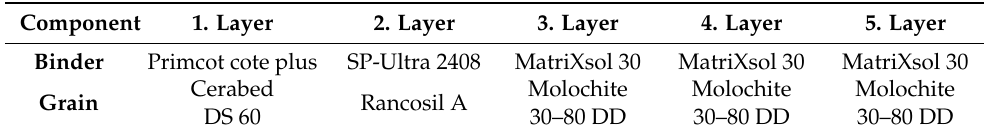
Figure 1. ( a ) Ceramic mold supplied by AluCAST s.r.o., ( b ) Scheme of test specimen. Table 2. Material composition of ceramic mold layers.